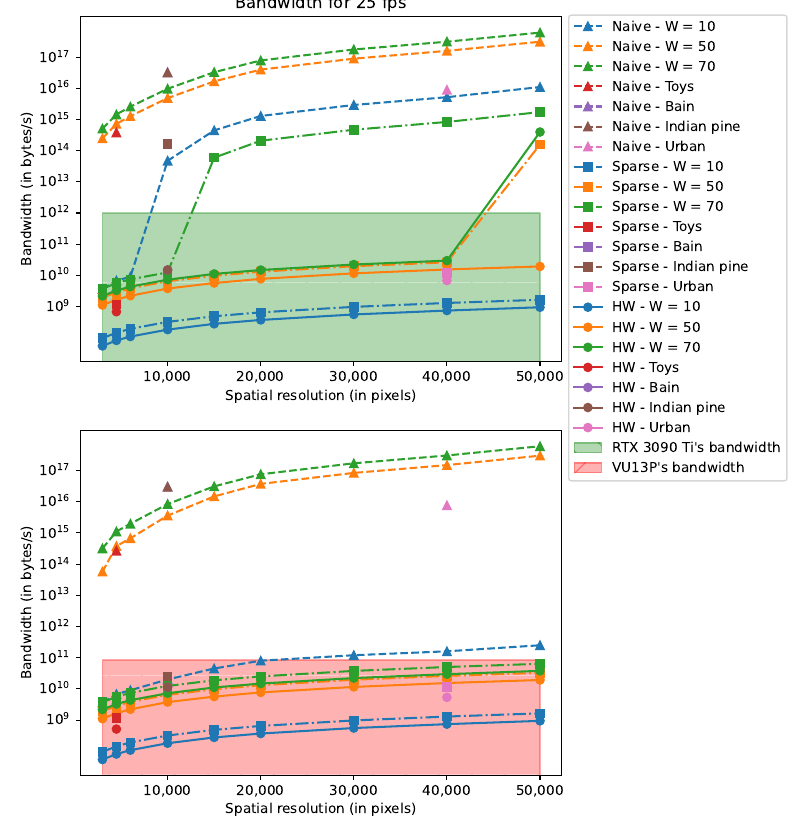
Figure 11. Bandwidth for 25-fps related to the RTX 3090 Ti and VU13P rated performances using the OR